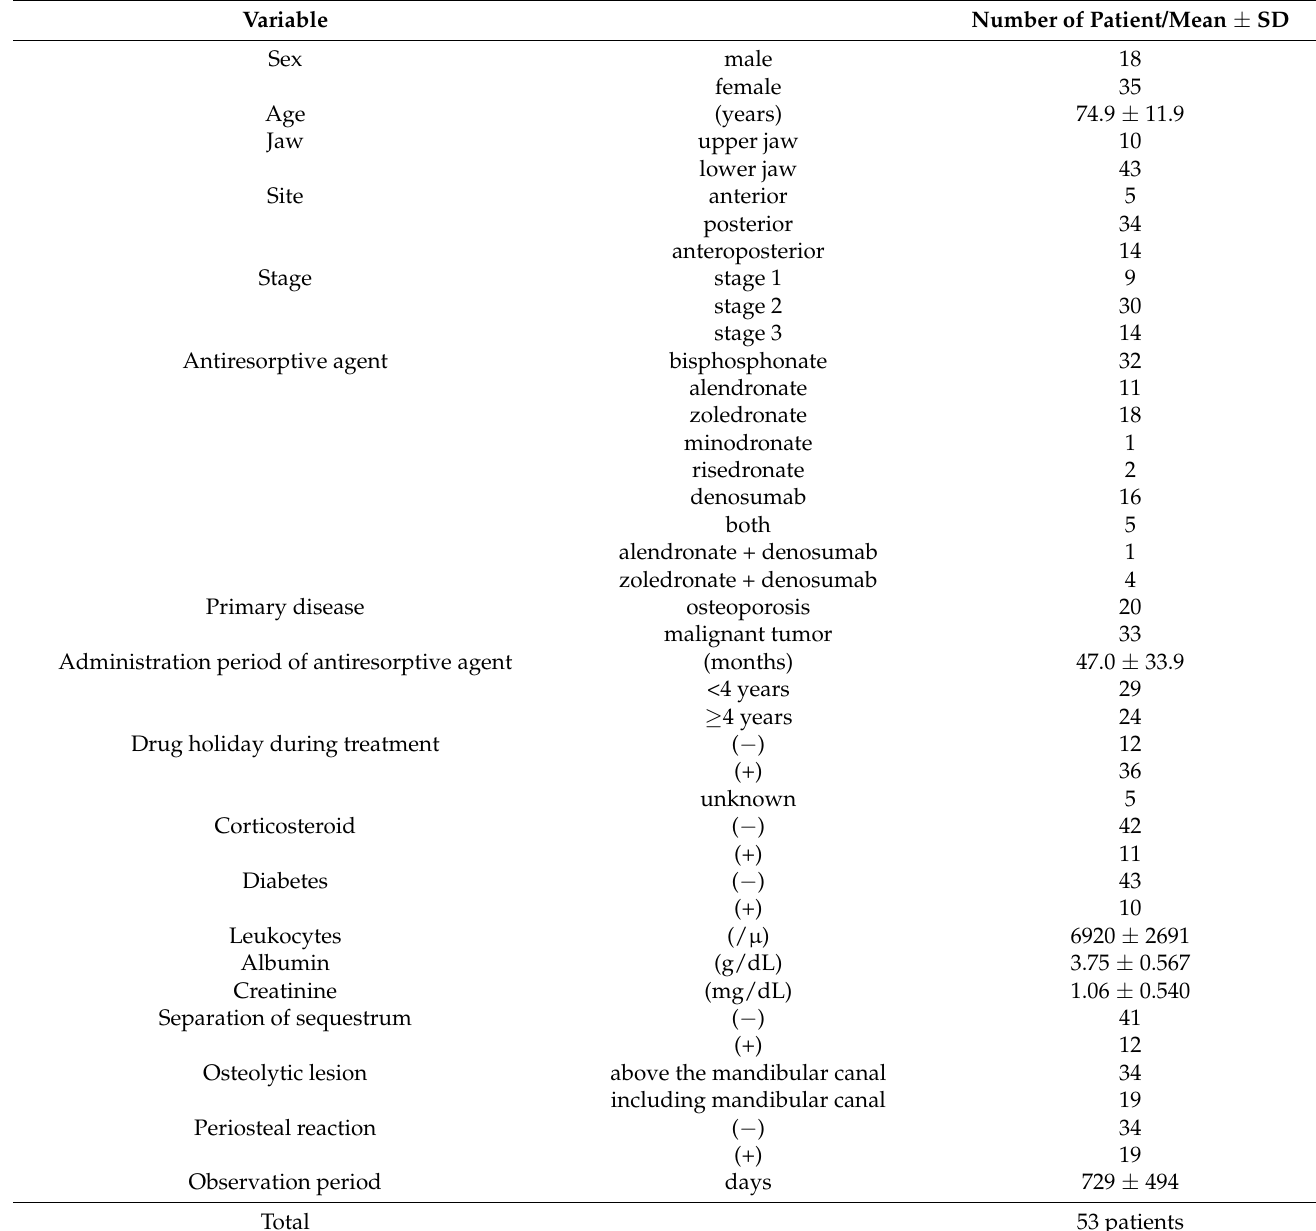
Table 1. Patient